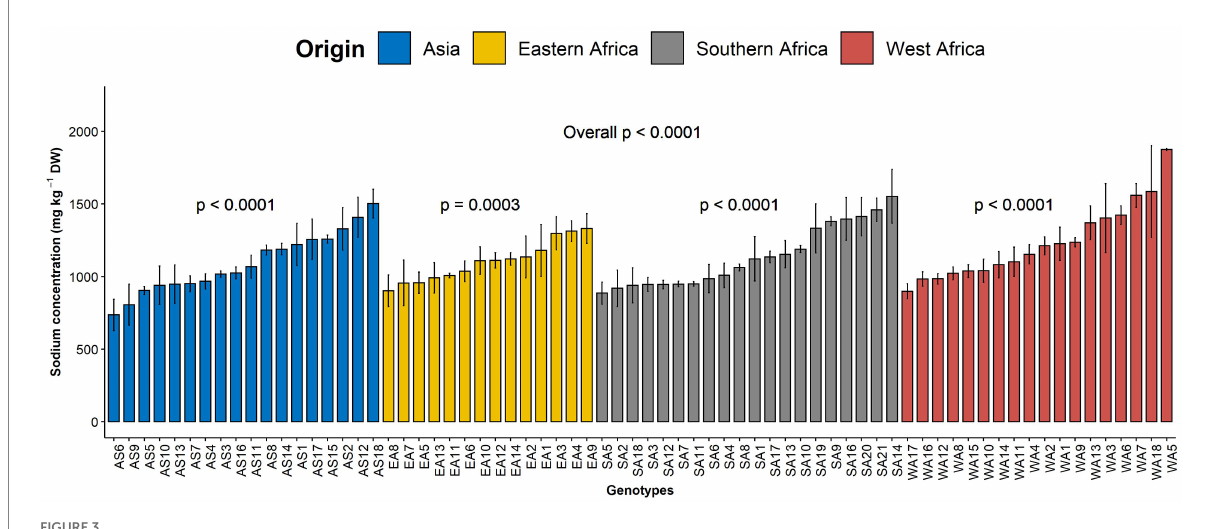
FIGURE 3 Variation in leaf sodium content among 70 advanced lines of G. gynandra evaluated in 2020 and 2021. Bar plots are the means, and error bars represent standard errors across years ( n =